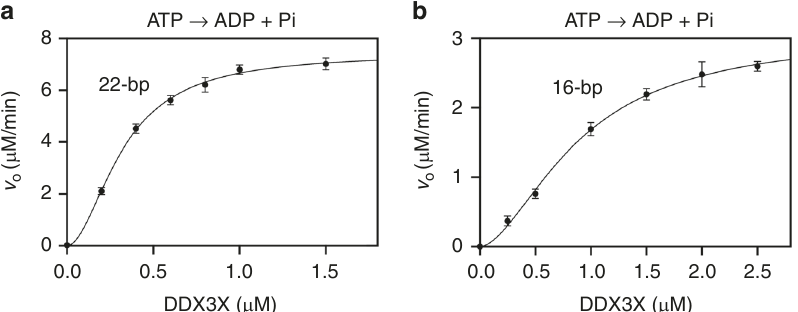
Fig. 4 Hill cooperativity analysis of the ATPase activity of human DDX3X. a ATPase activity of DDX3X was stimulated by 100nM 22-bp double-stranded RNA (dsRNA) with a 25-nt 3 ʹ overhang (Strand 1: 5 ʹ -UCGUGGCAUUUCUGCGUCGUUCUUUUCUUUUCUUUUCUUUUCUUUUC-3 ʹ ; Strand 2: 5 ʹ -GAACGACGCAG AAAUGCCACGA-3 ʹ ) at indicated concentrations of the helicase. Solid line is the best fi ts to the Hill equation ( V max = 7.4±0.3 μ Mmin − 1 , K 1/2 = 320±20nM, H = 1.9±0.2). b ATPase activity of DDX3X was stimulated by 100nM 16-bp dsRNA with a 25-nt 3 ʹ overhang (Strand 1: 5 ʹ -GCGUCUUUACGGUGCUU AAAACAAAACAAAACAAAACAAAA-3 ʹ ; Strand 2: 5 ʹ -AGCACCGUAAAGACGC-3 ʹ ) at indicated concentrations of the helicase. Solid line is the best fi ts to the